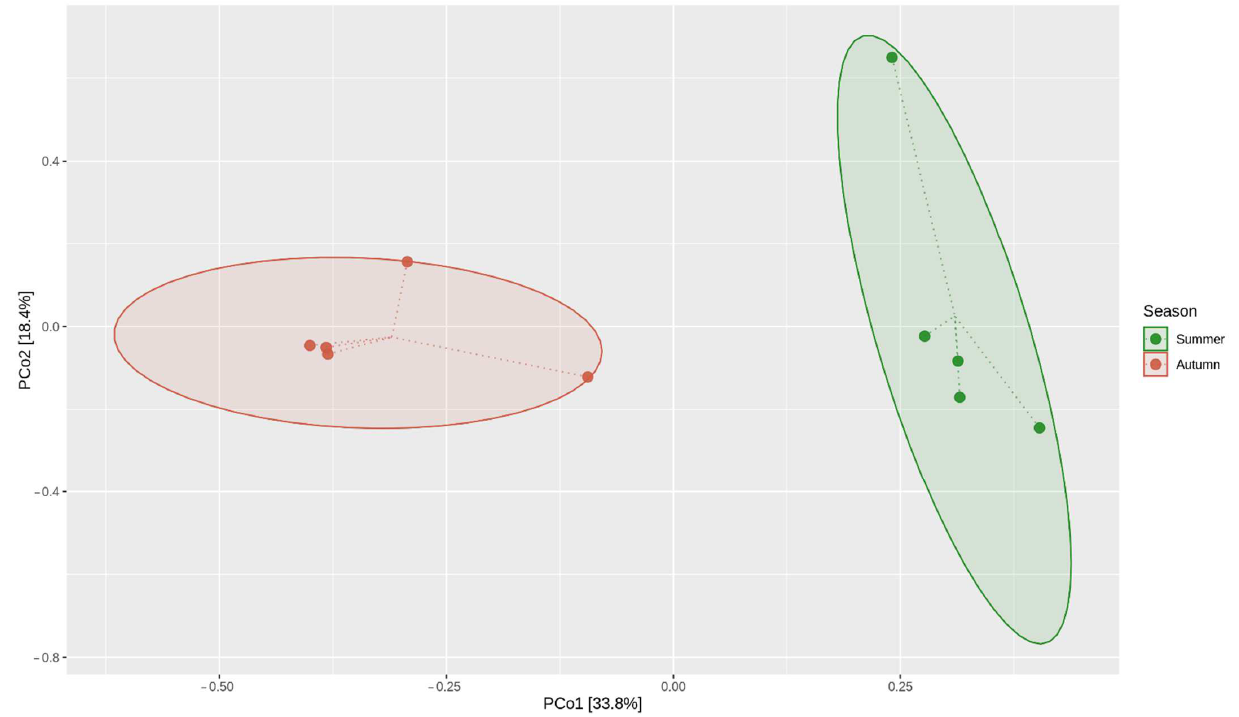
Figure 6. Principal coordinate analysis (PCoA) based on the overall structure of the endosphere microbiota in all samples. The data used for the PCA analysis are data derived from metagenomic studies (16S rDNA amplicon sequencing). Each data point represents an individual sample. PCoA was calculated using Bray–Curtis distances with a multivariate t-distribution. Ellipses represent a 90% confidence level. Colour is indicative of cohort.